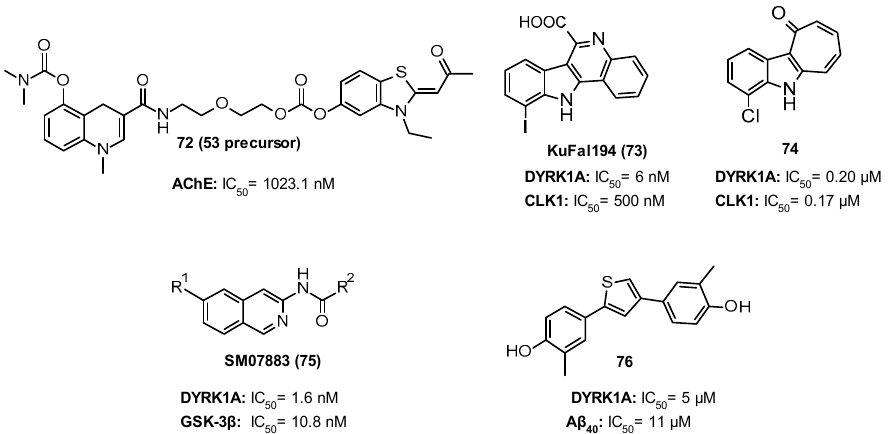
Figure 13. Chemical structures of multi-target DYRK1A inhibitors.